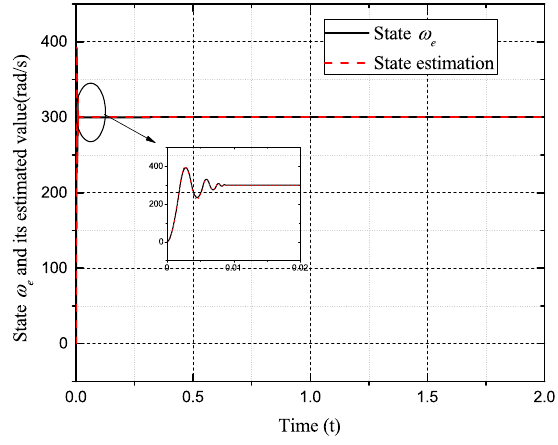
Figure 9. State ω e and its estimated value ˆ ω e